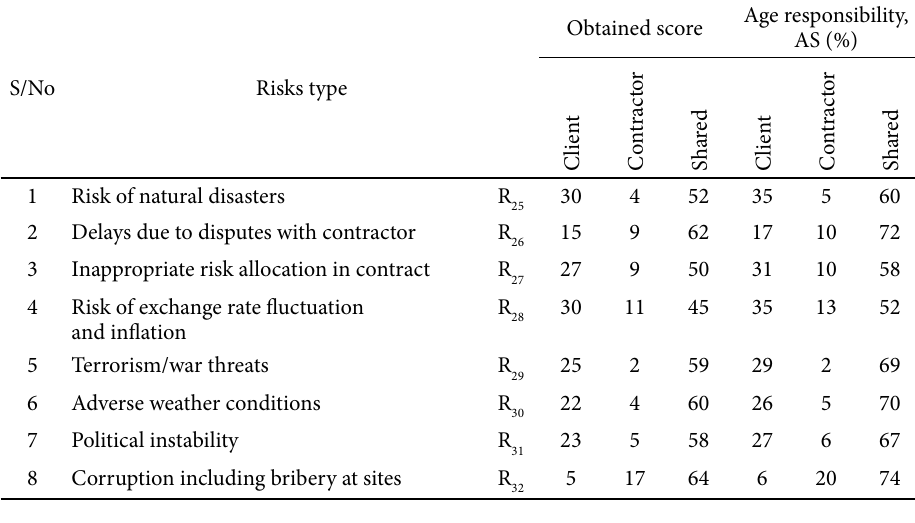
Table 3. Shared Responsibility